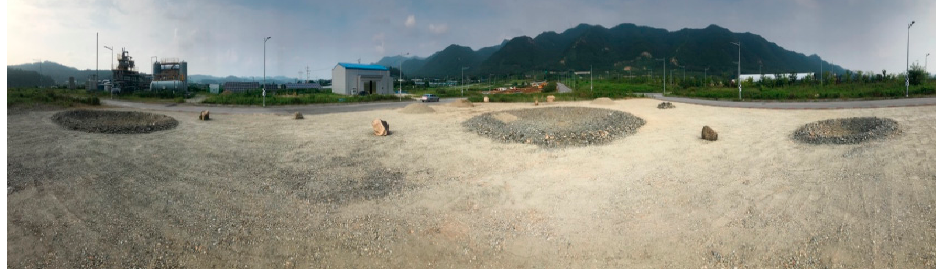
Figure 5. Emulated planetary terrain at